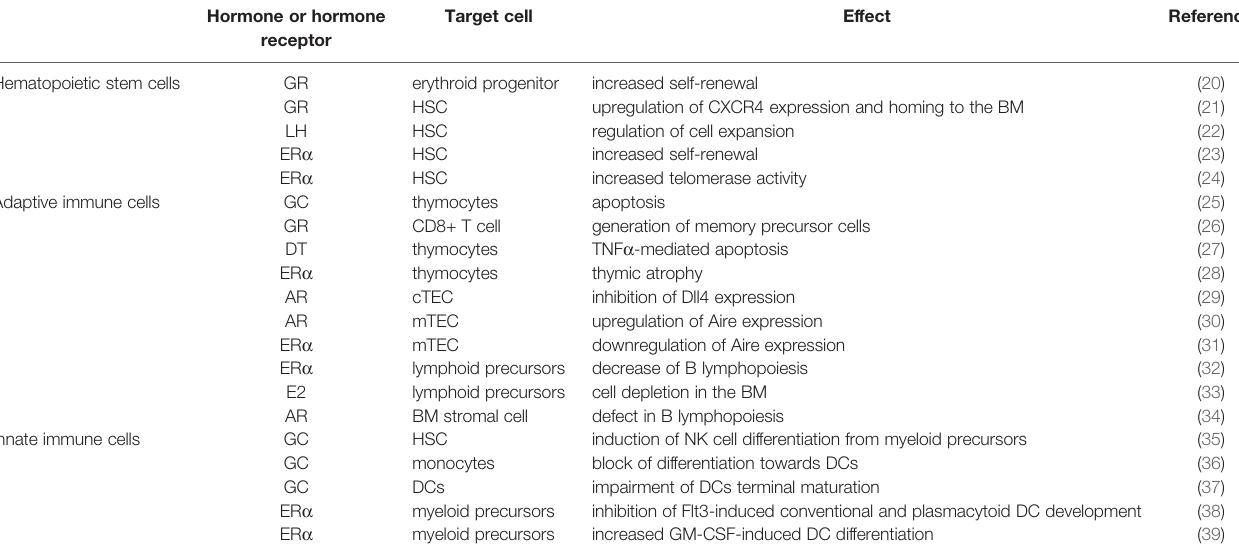
TABLE 1 | Summary of the main effects of GCs and sex hormones on HSC, adaptive and innate immune